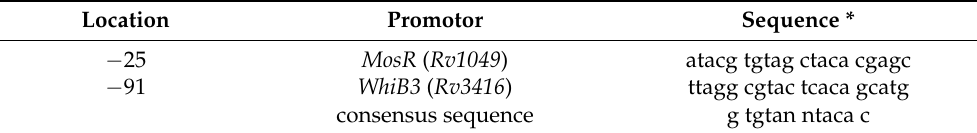
Table 2. Putative MosR binding site in the whiB3 promoter region of M. tuberculosis .